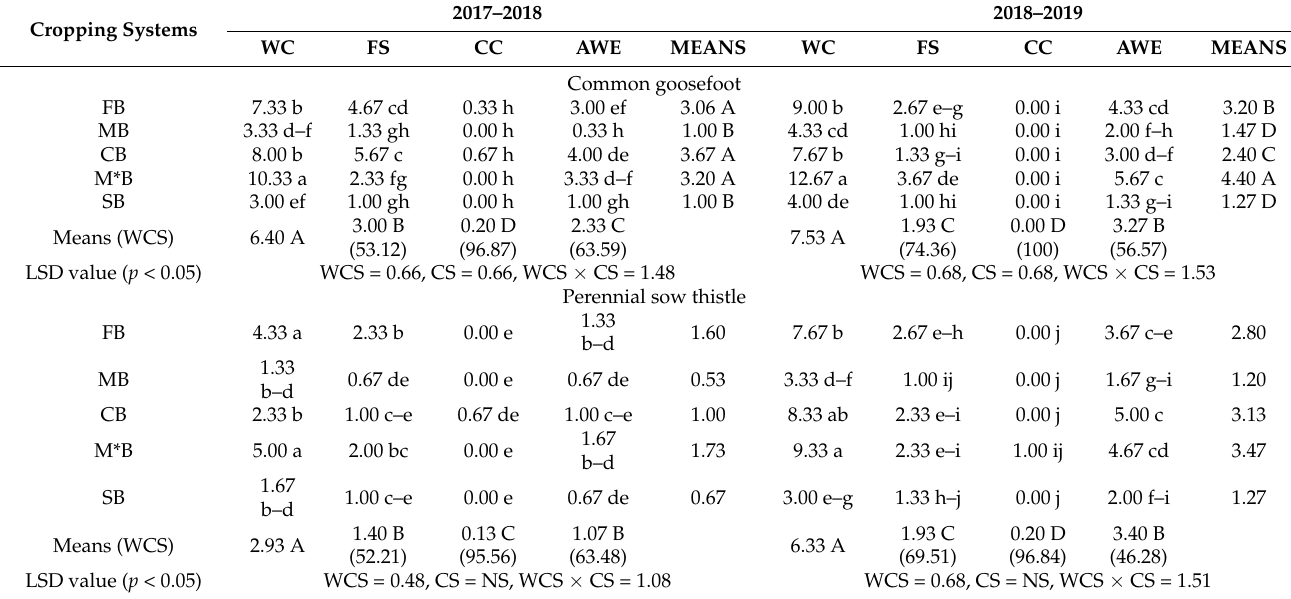
Table 4. Influence of different barley-based cropping systems on individual density (m − 2 ) of